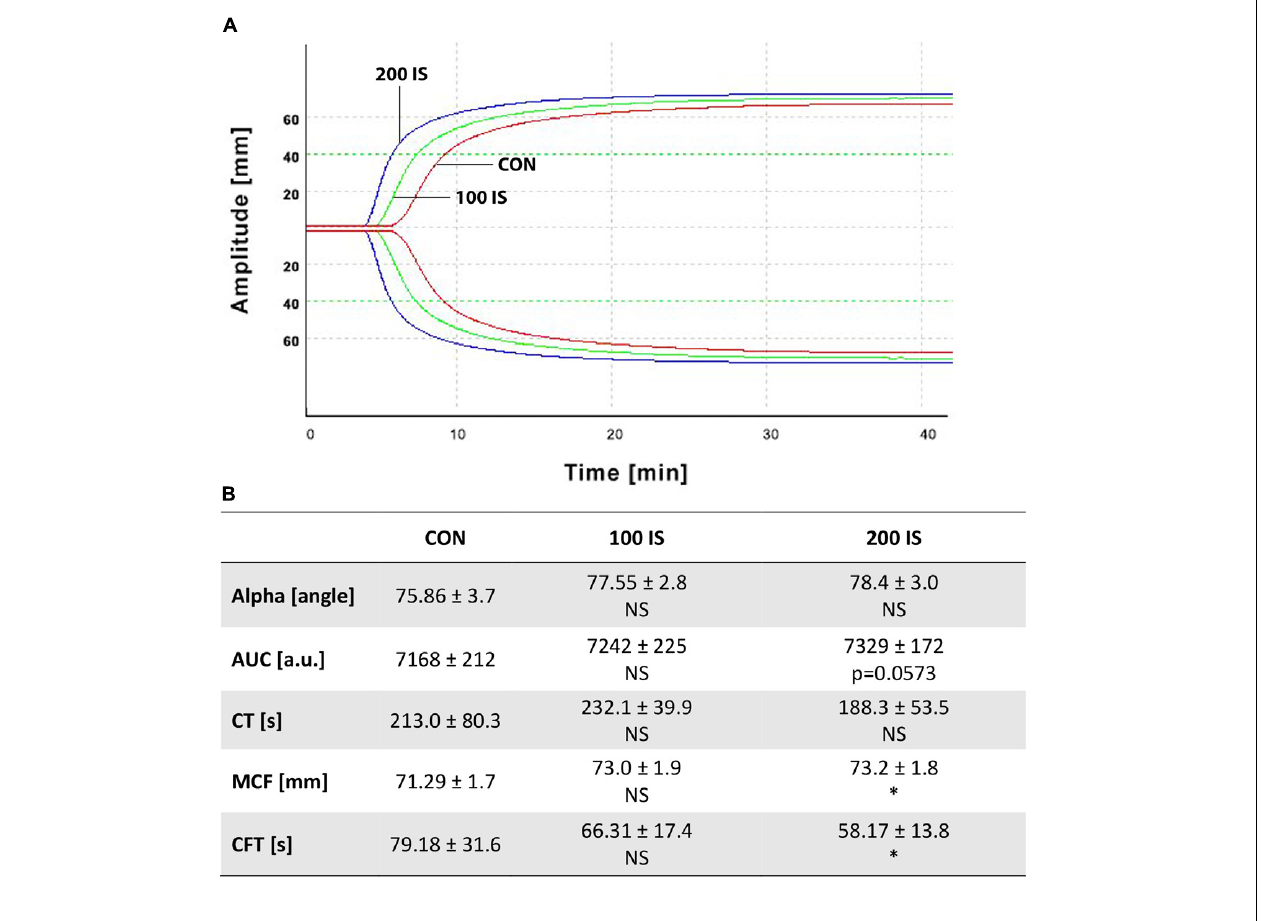
FIGURE 3 | (A) Graphical representation of influence of IS on ROTEM analyses. (B) Impact of IS on kinetics and strength of clot formation. Data from (B) are shown as the mean ± SD. CON, control group; 100 IS, group receiving IS in the dose of 100 mg/kg b.w./day; 200 IS, group receiving IS in the dose of 200 mg/kg b.w./day; a.u., arbitrary units; AUC, area under the curve; CFT, clot formation time; CT, clotting time; IS, indoxyl sulfate; MCF, maximum clot firmness; NS, non-significant; ∗ p < 0.05 compared to control. TABLE 3 | Influence of IS on coagulation parameters. CON 100 IS 200